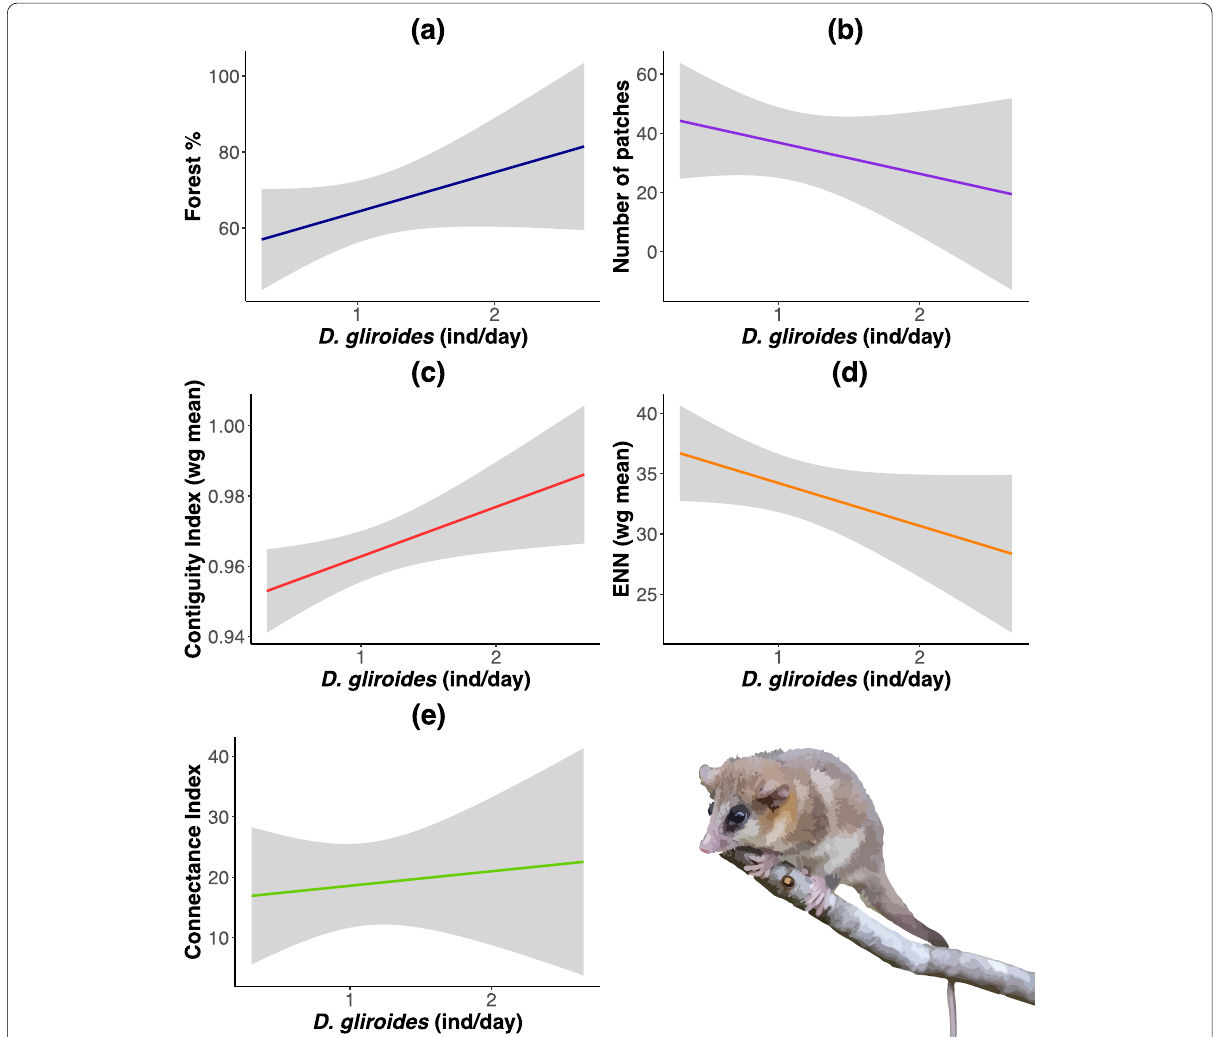
Fig. 4 Linear relationships of landscape metrics and Dromiciops gliroides abundance. Landscape metrics used: ( a ) proportion of forest cover in the landscape (PLAND), ( b ) number of patches (NP), ( c ) contiguity index (CONTIG, weighted mean), ( d ) Euclidean distance to the nearest neighbor (ENN, weighted mean), and ( e ) connectivity index (CONNECT, measured at 250 m). Shaded areas represent 95% confidence